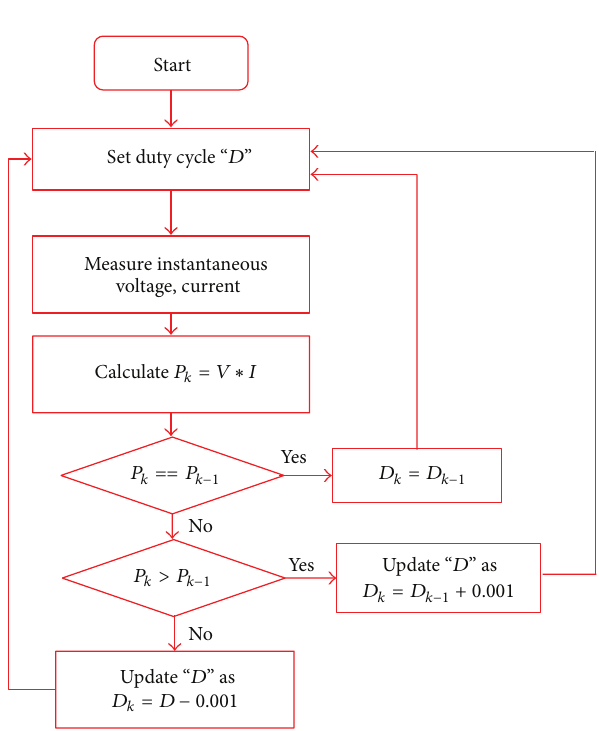
Figure 16: Flowchart of MPPT